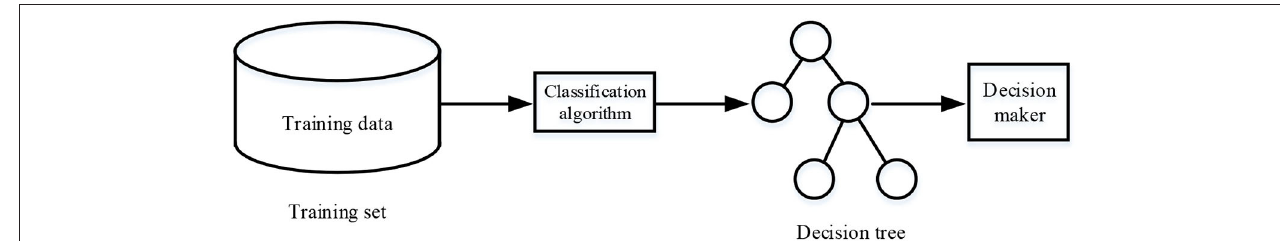
FIGURE 9 | Flowchart of decision trees.